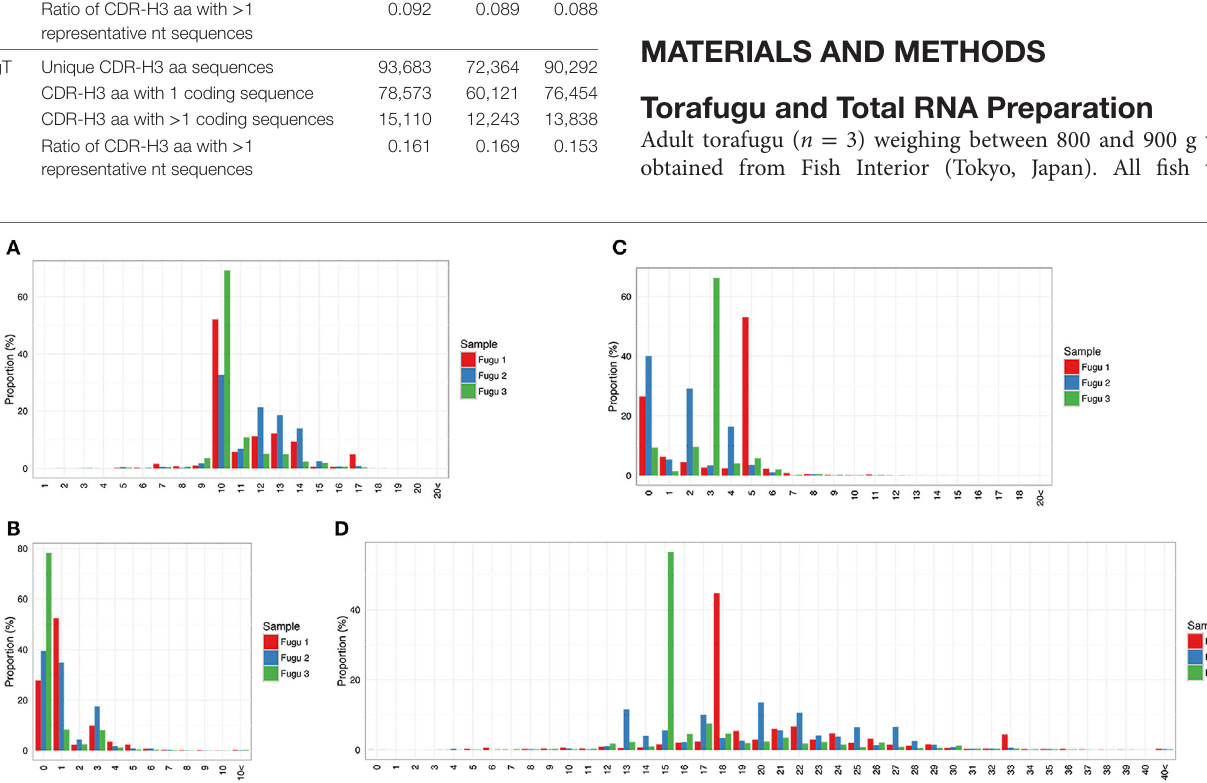
FigUre 5 | Sequence diversity of heavy (H) chain complementarity-determining region 3 (CDR-H3) repertoire in IgT. (a) Distribution of CDR-H3 amino-acid length. (b,c) Distribution of the total number of nucleotide deletions and (D) V–J insertion.